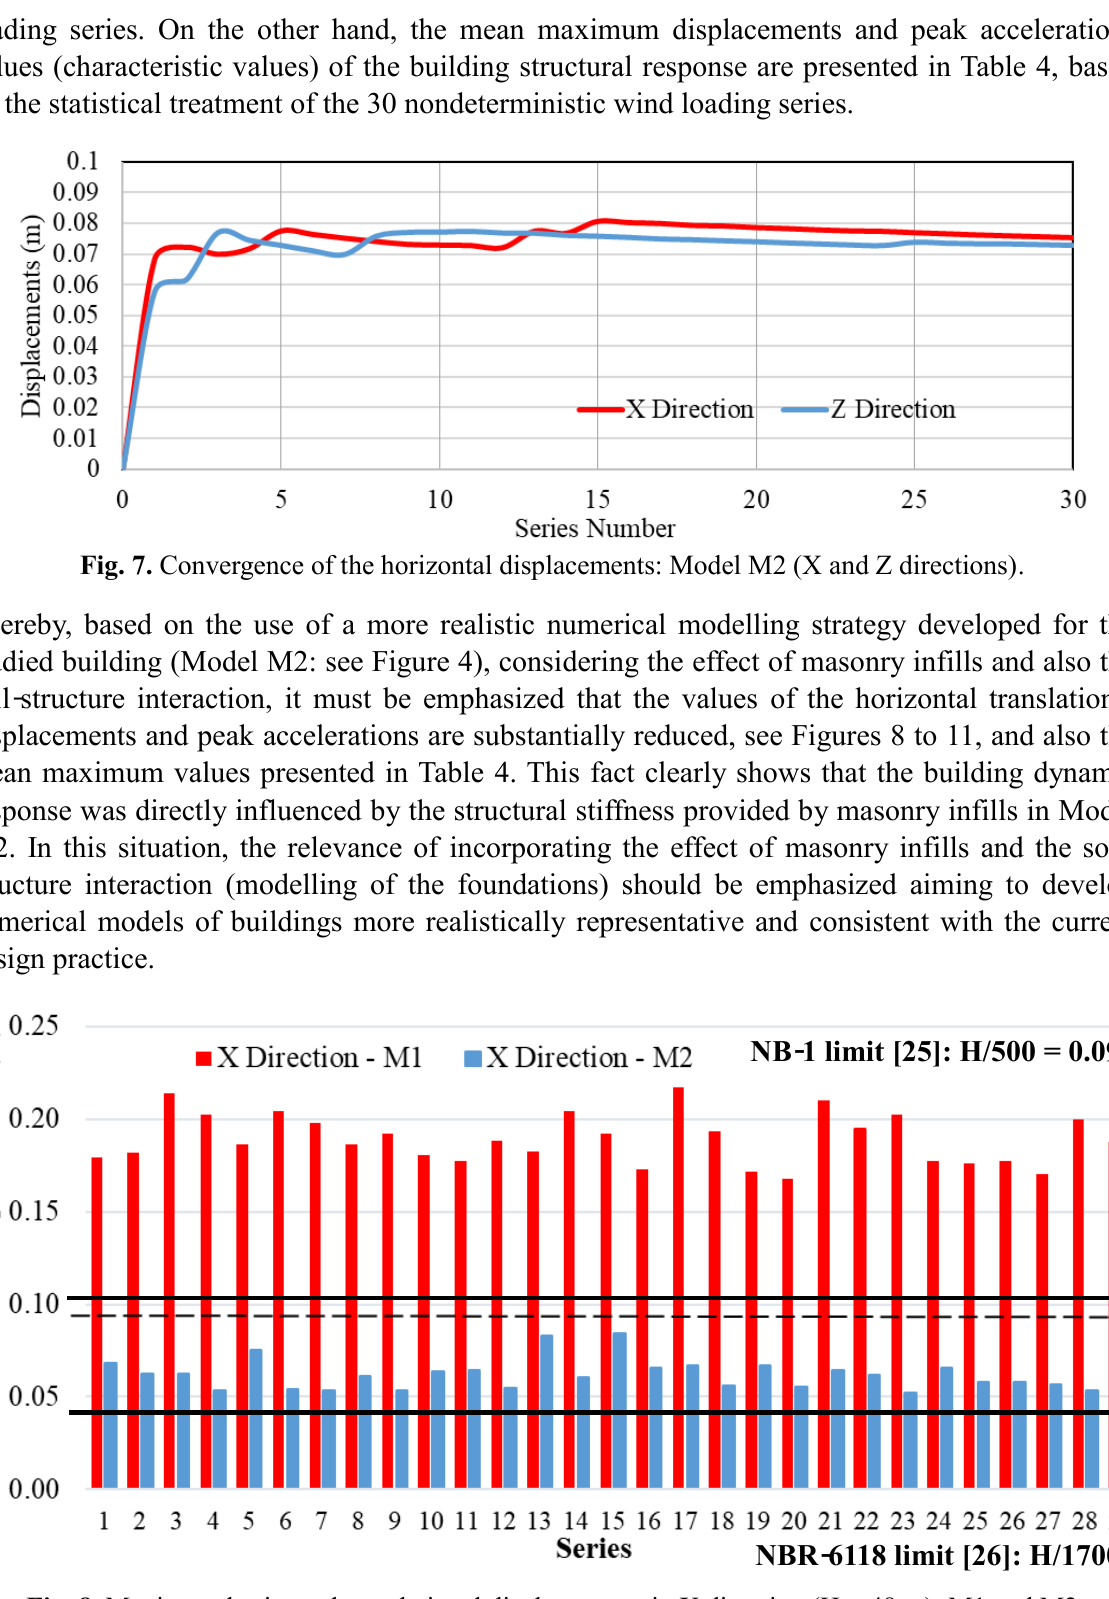
Fig. 8. Maximum horizontal translational displacements in X direction (H = 48 m): M1 and M2